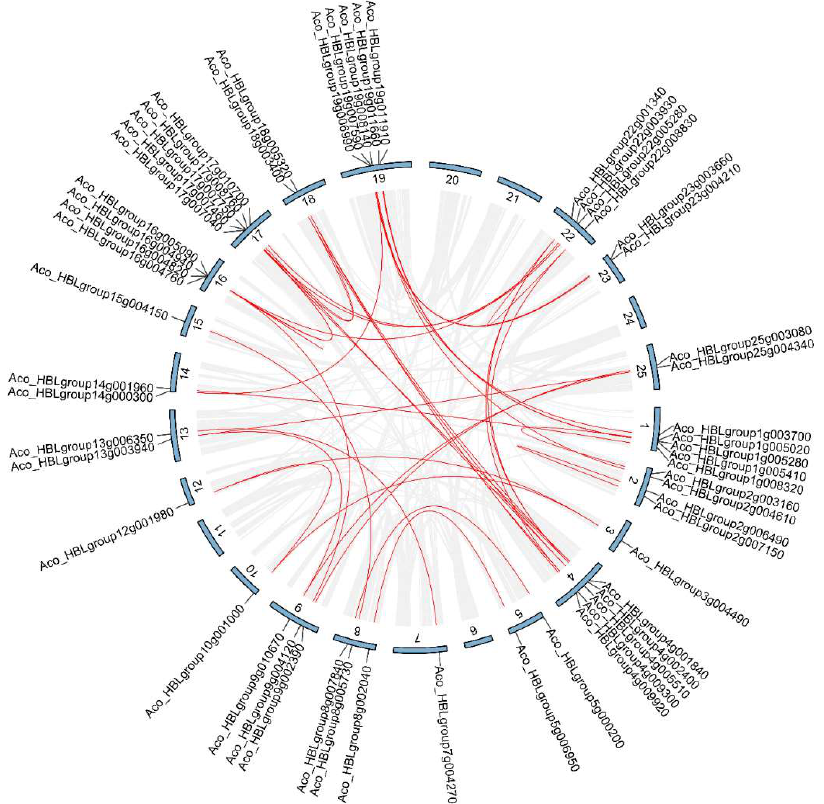
Figure 4. Gene duplication events of AbR2R3-MYB gene family in A. comosus var. bracteatus . Grey lines represent all synteny blocks in the genome, red lines suggest replicated AbR2R3-MYB gene pairs. The chromosome number is at the bottom of each chromosome.